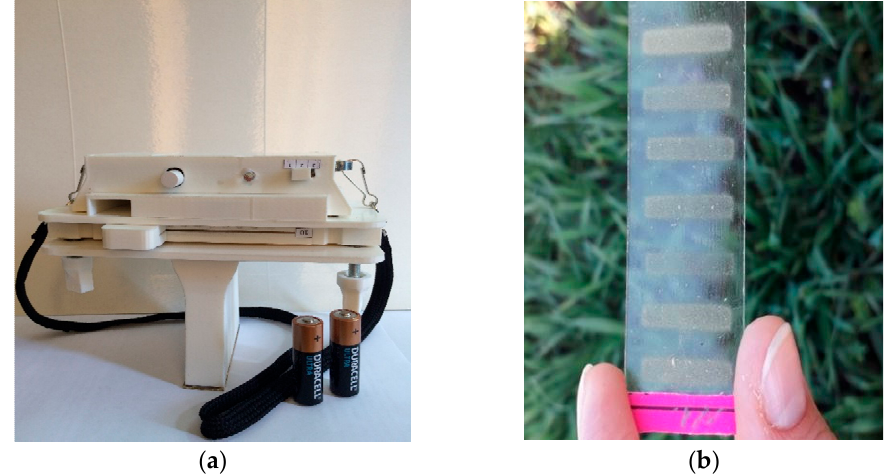
Figure 1. The device used in the study of aerogenic infection in wheat crops: ( a ) portable device for determining the infestation of plants; ( b ) sample prints.